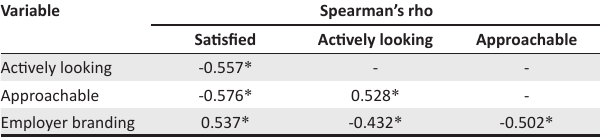
TABLE 5: Spearman’s rho tests for employee retention and employer branding.